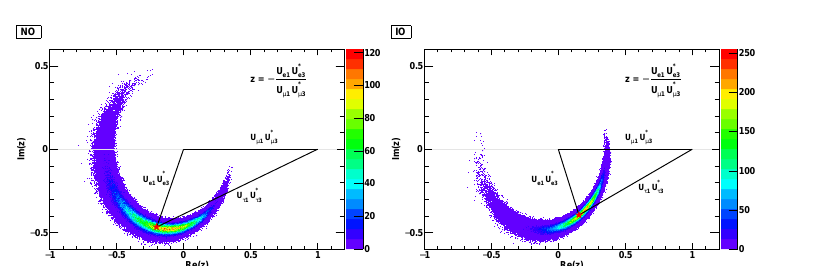
Figure 4.3: Plot of δ CP with the four oscillation parameters having 1 σ uncertainties of ± 23 o . (Hyper-K)